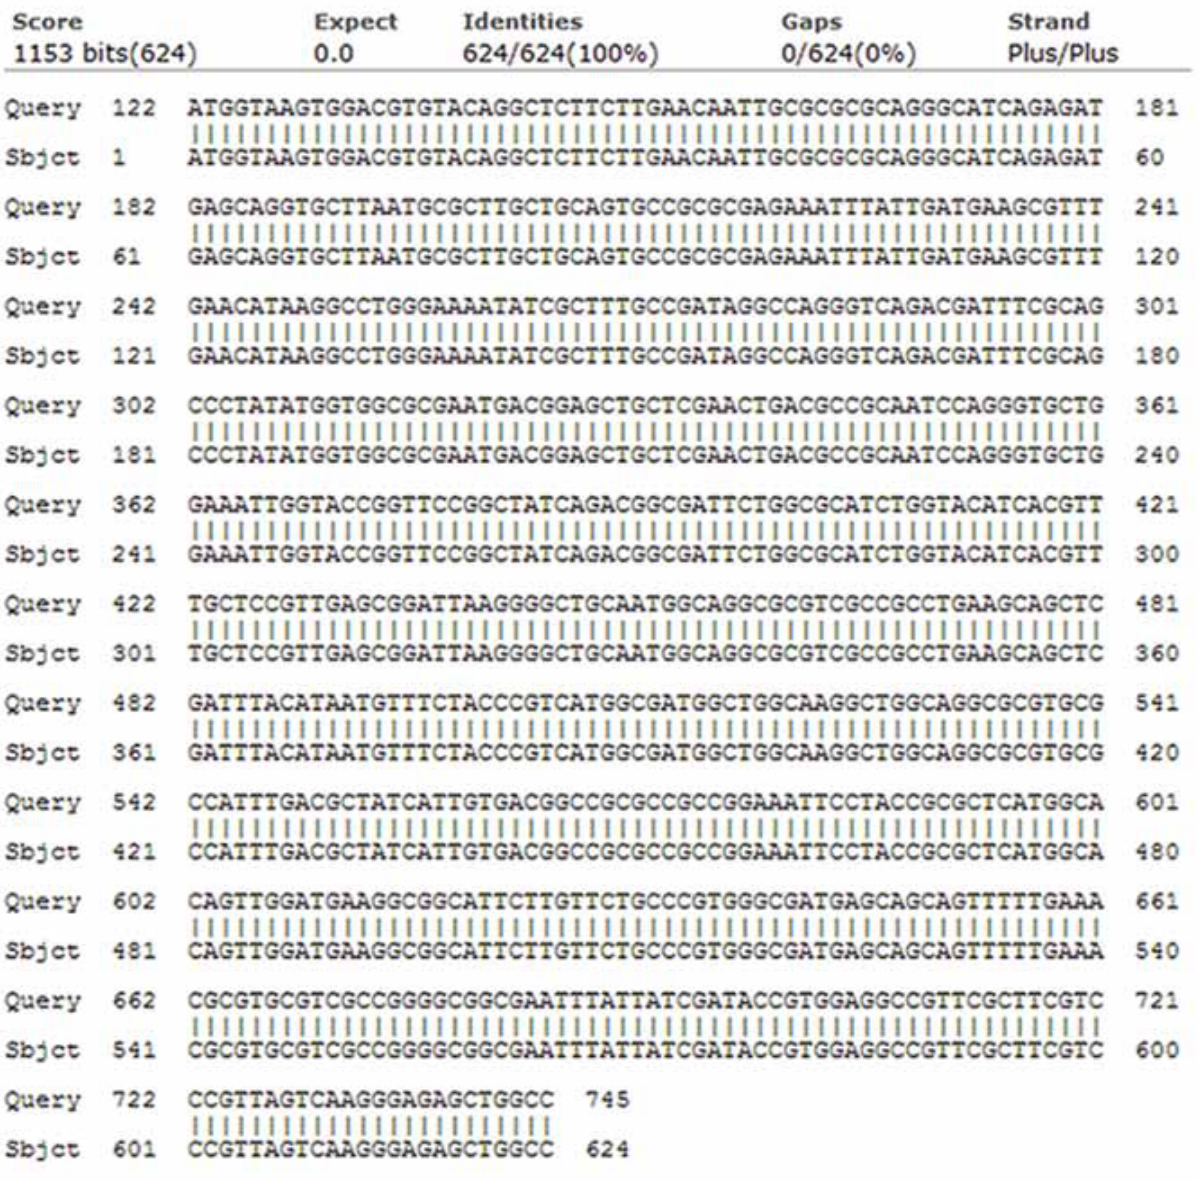
Figure-3: Sequence analysis of protein L -isoaspartyl O -methyl transferase (PIMT) from positive clones resembling 100% homology: Query-PIMT sequence obtained by sequencing, subject-retrieved PIMT sequence of S . Typhimurium LT2 strain from